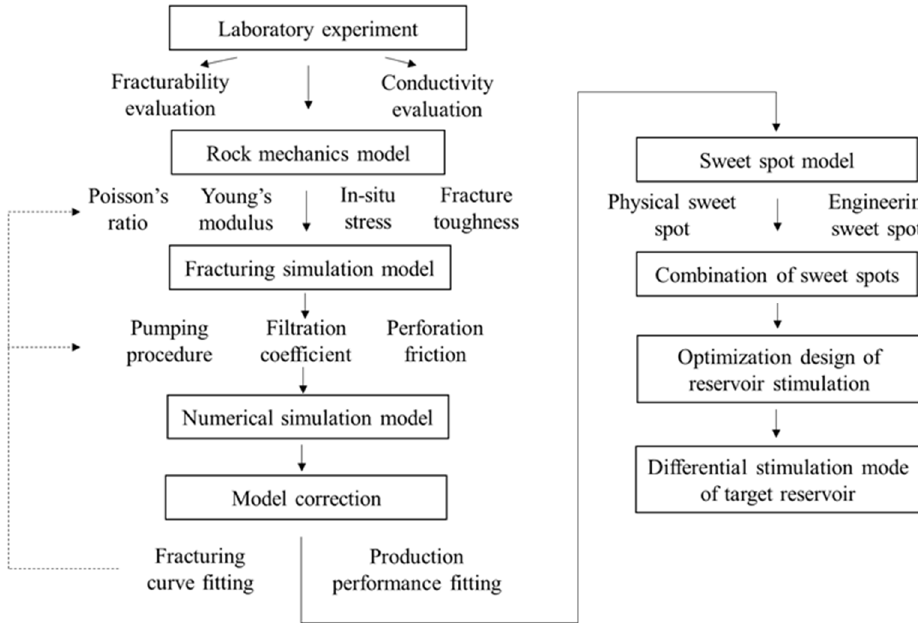
Figure 1. The strategy of integrated reservoir model and differential stimulation modes.